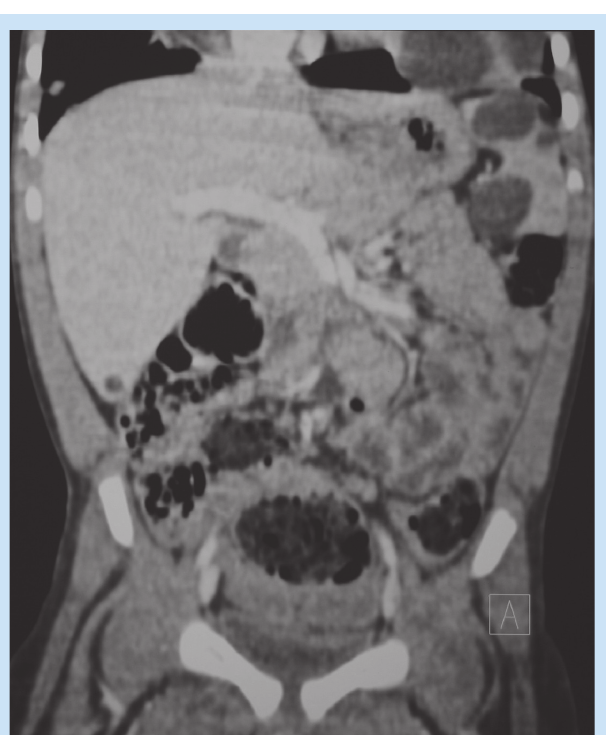
Fig. 3. Coronal CT scan of the abdomen. Three cysts noted in the spleen, as well as a solitary cyst in the inferior region of the